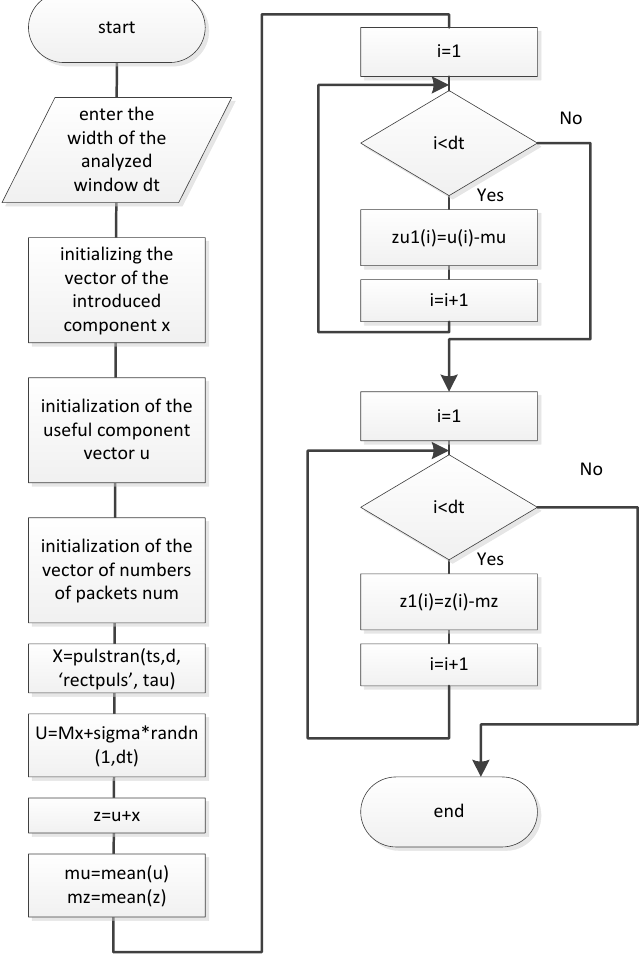
Figure 3. Algorithm for specifying the legitimate and illegitimate traffic.